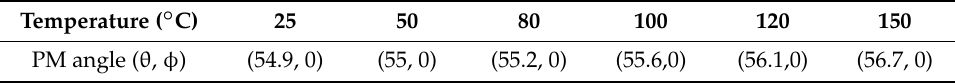
Table 5. Calculated phase matching angles for 1064 nm → 3900nm + 1463 nm